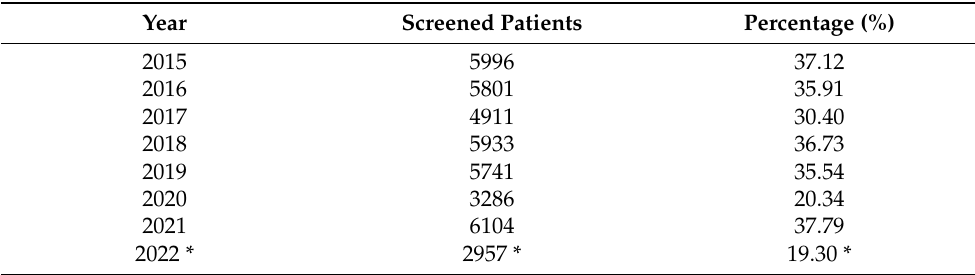
Table 1. DR screening results, number of patients screened and percentage with respect to the total number of patients with DM in the